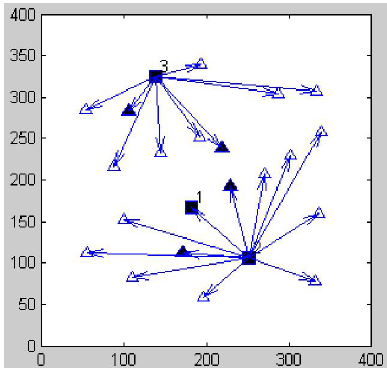
Fig. 12. Three-layer LRP transshipment paths for Product